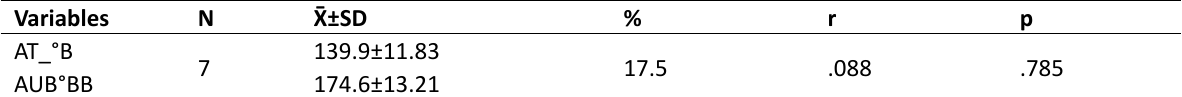
Table 3. Functional active flexibility “Arm-Trunk Angle Backward (AT_°B)” during the execution of techniques requiring mobility “Arm-Upper Body Angle Backward in Bridge Technique